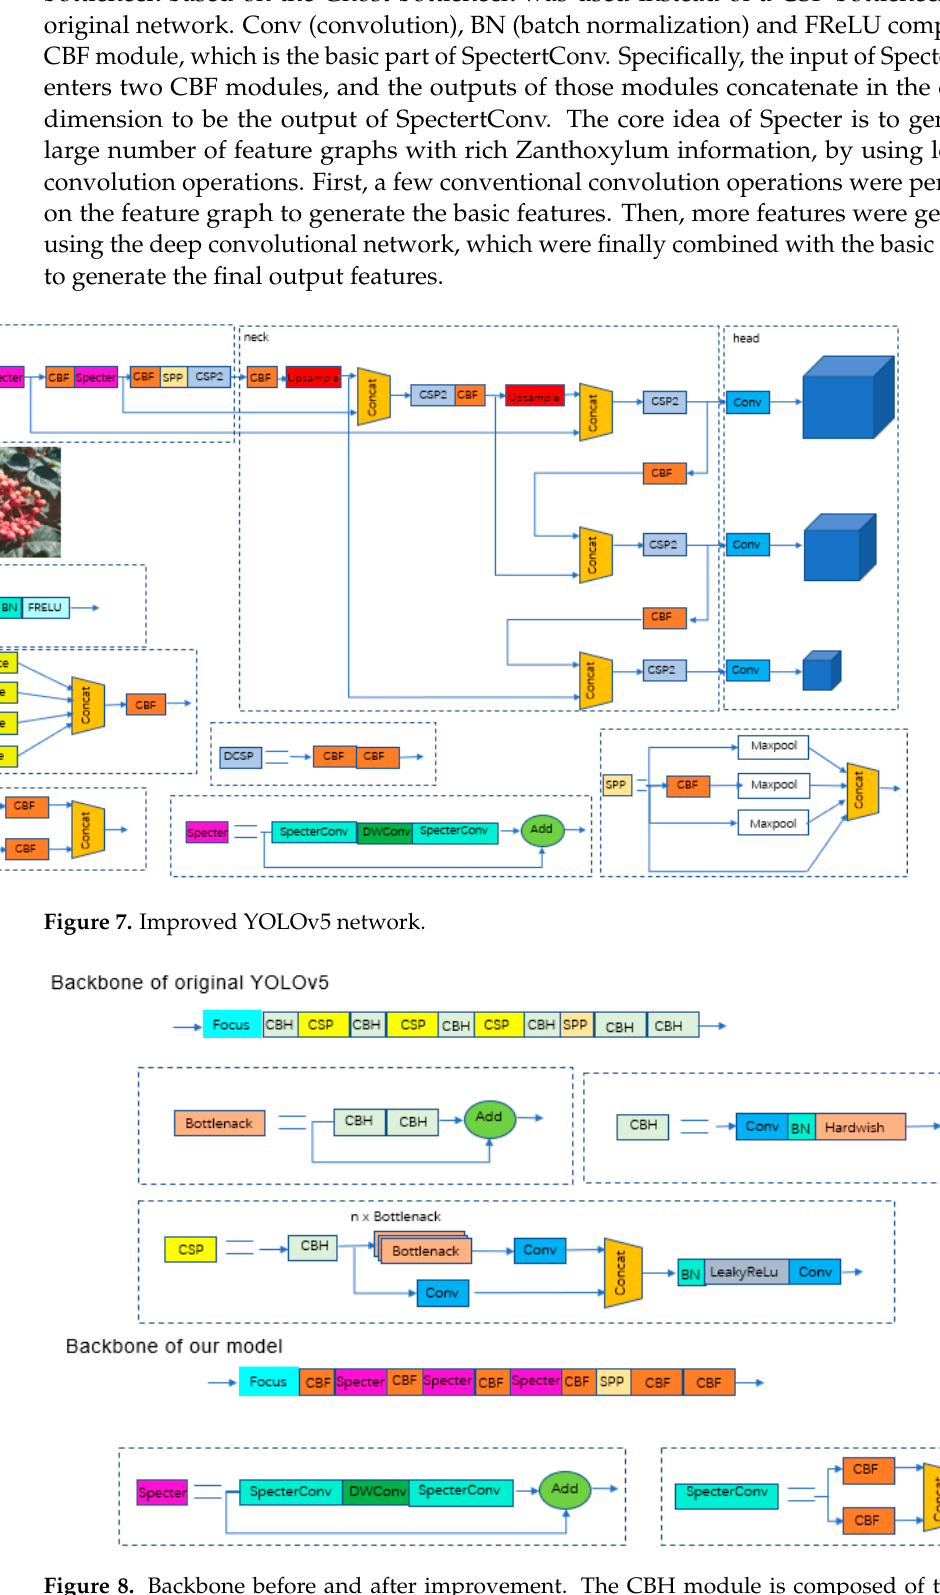
Figure 6. Comparison of different versions of YOLOv5s.